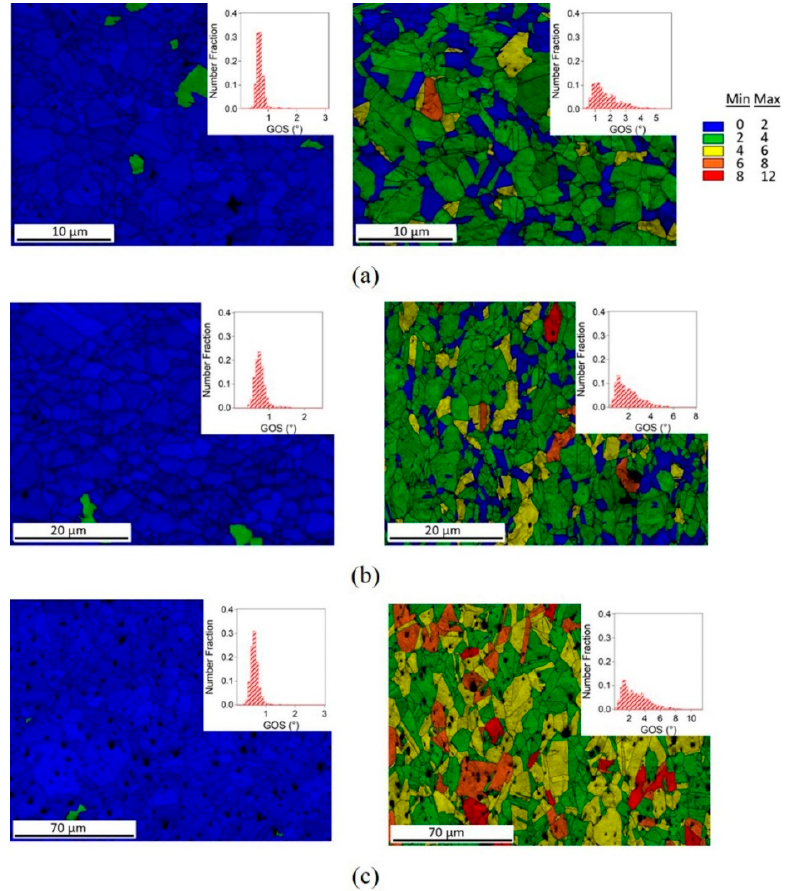
Figure 9. Grain orientation spread (GOS) + IQ map of samples 1 (d = 0.82 µm) ( a ), 3 (d = 1.39 µm) ( b ) and 4 (d = 4.0 µm) ( c ) at the initial state (left) and deformed state at fracture (right). Color legend represents the orientation spread in degrees. Inserts display the distribution of GOS values for each state and